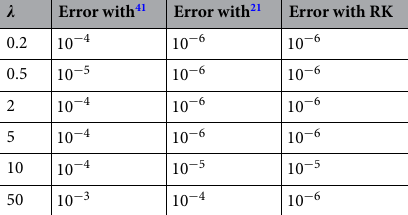
Table 3. Assessment of the numerical values of method with already existing results 21,40 when M